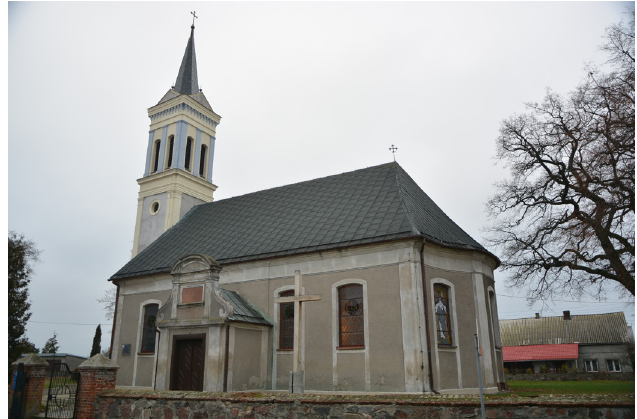
Figure 1 Rodowo Church exterior. This and all the following photos were taken by the